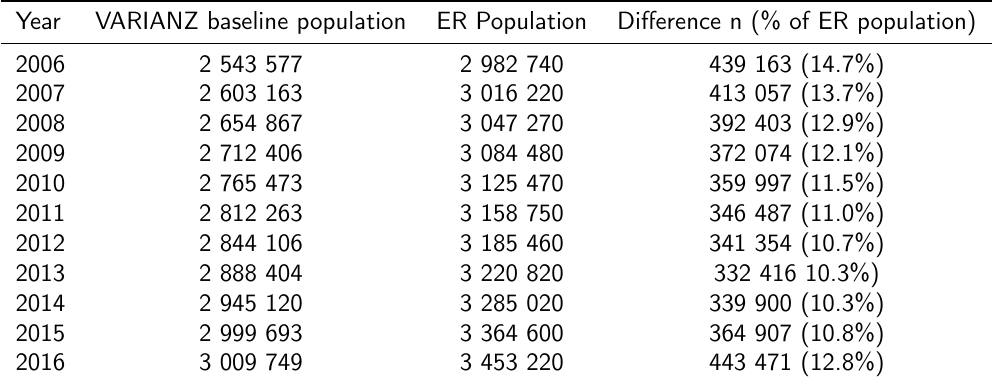
Table 4: Vascular Risk in Adult New Zealanders (VARIANZ) baseline population aged 20 years or older compared to the New Zealand Estimated Resident (ER) population estimates* for 2006-2016